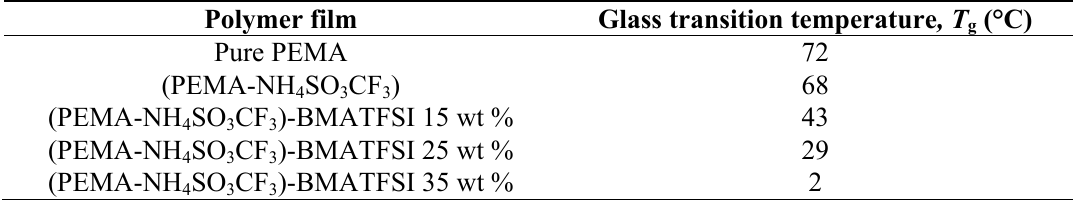
1. Glass transition temperature of PEMA-NH electrolyte films. Where PEMA is poly ethyl methacrylate, BMATFSI is butyl trimethylammonium bis